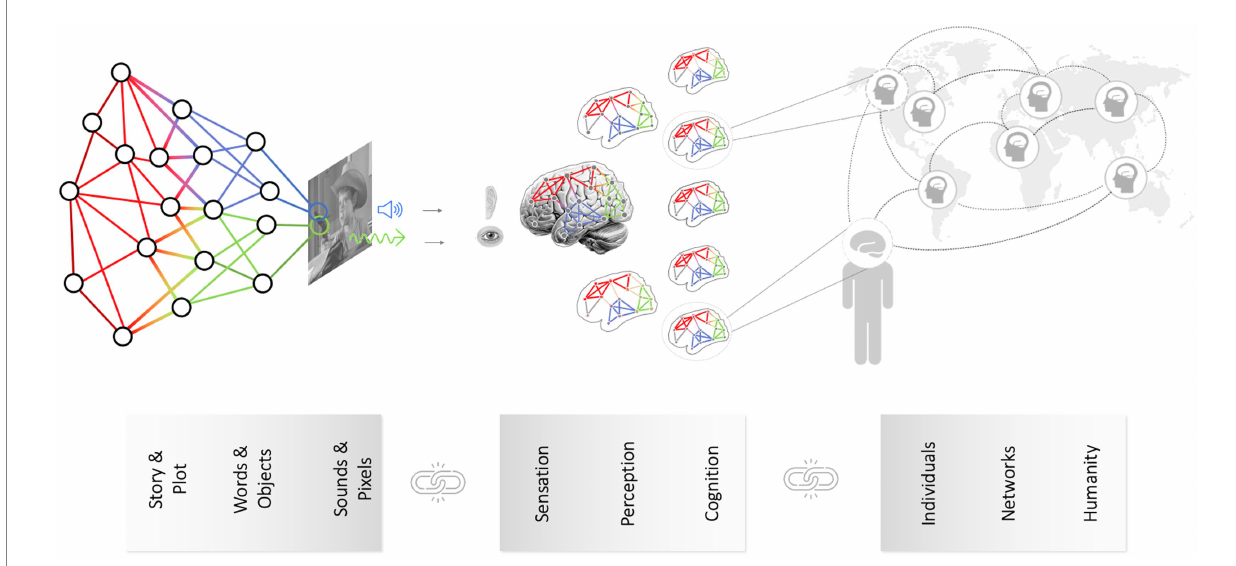
FIGURE 4 Linking hierarchies of content with matching reception mechanisms and integration with media effects. Content is a deceptively singular word, but it encompasses multiple layers - from manifest (e.g., pixels) to latent content (e.g., subtext, story morals). Understanding content as a network of information layers (left panel) allows for its comprehensive quantification, facilitating the identification of corresponding reception mechanisms. In a similar fashion, we can also integrate individual-specific neurocognitive processes during media reception to media effects and social